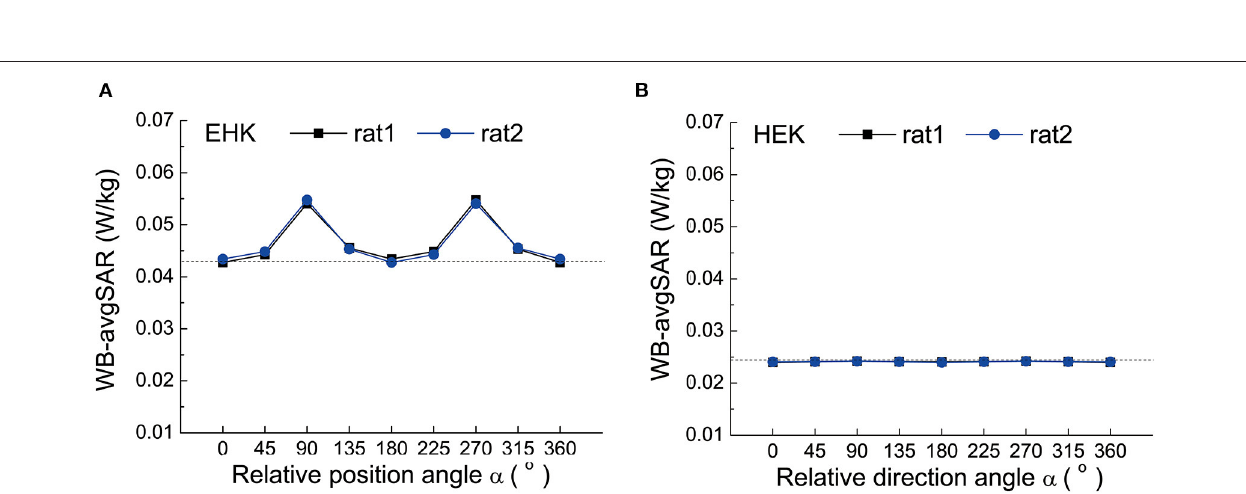
FIGURE 3 | The whole-body average SAR (WB-avgSAR) of two rats in different horizontal distance d . (A) The simulation results under EHK; (B) The simulation results under HEK.